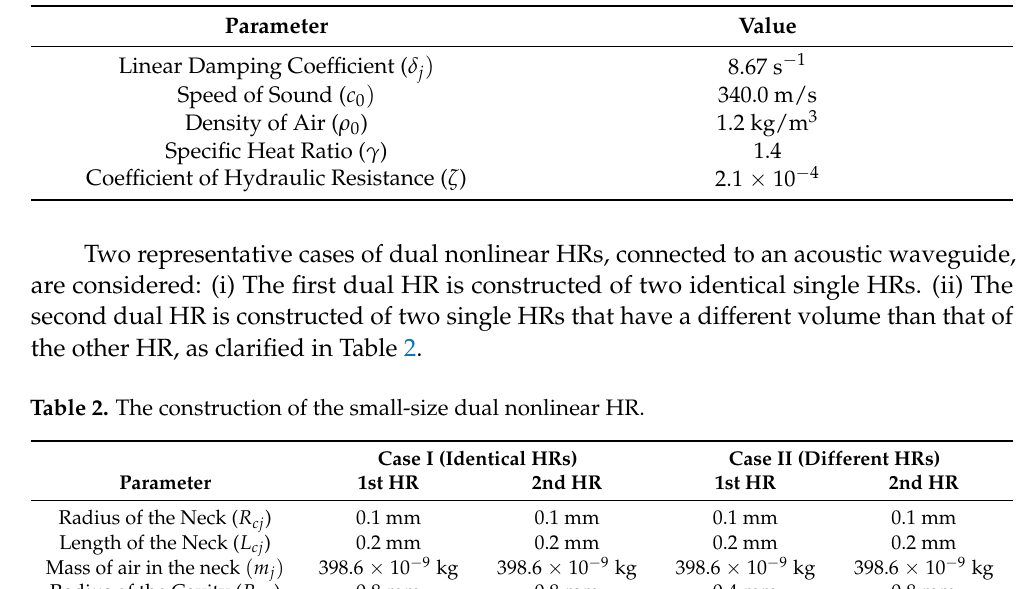
Table 1. Physical Parameters of the dual nonlinear HR.